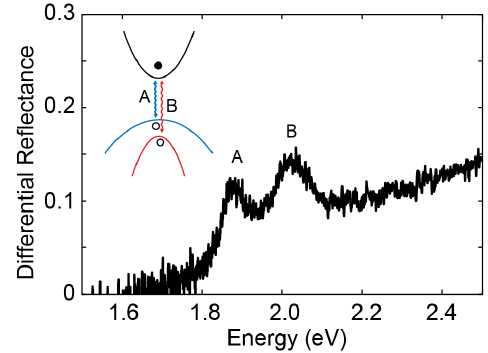
Figure 2. Differential reflectance spectrum of a single ‐ layer MoS 2 triangle showing A and B exciton peaks. Inset: schematic drawing of the band diagram of single ‐ layer MoS 2 indicating the A and B excitons at the K point.